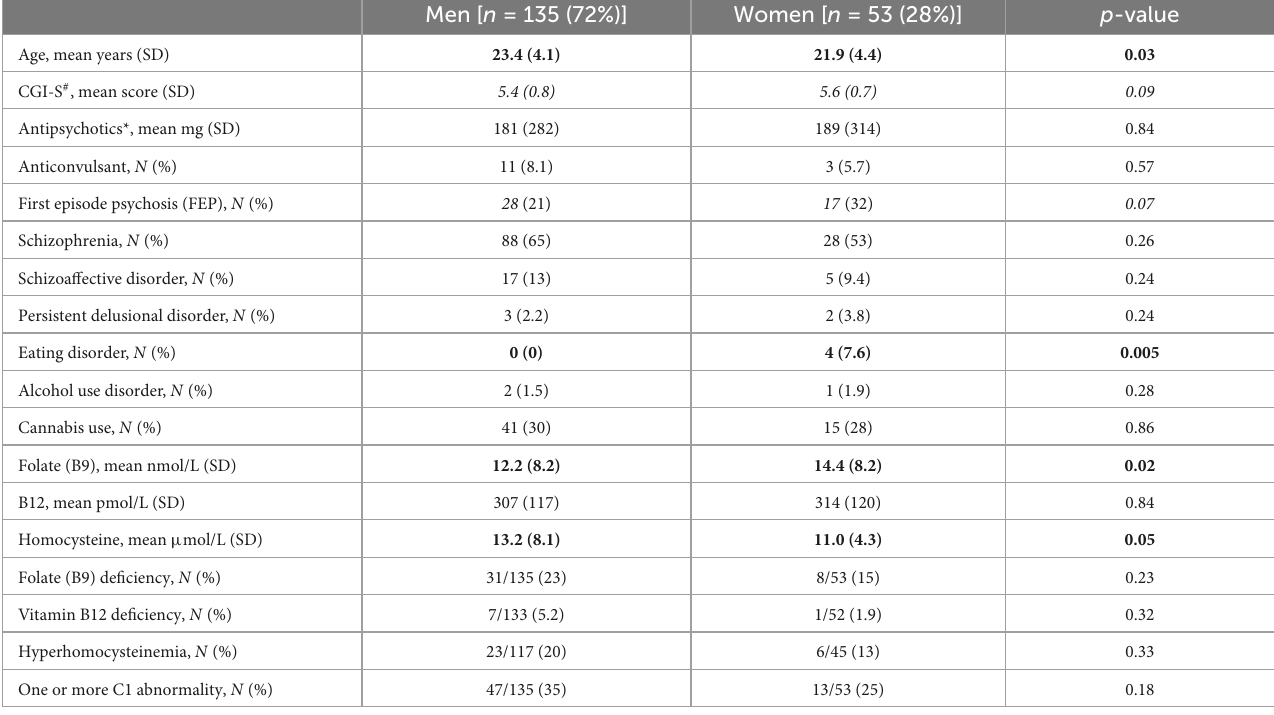
TABLE 2 Clinical and biological characteristics according to